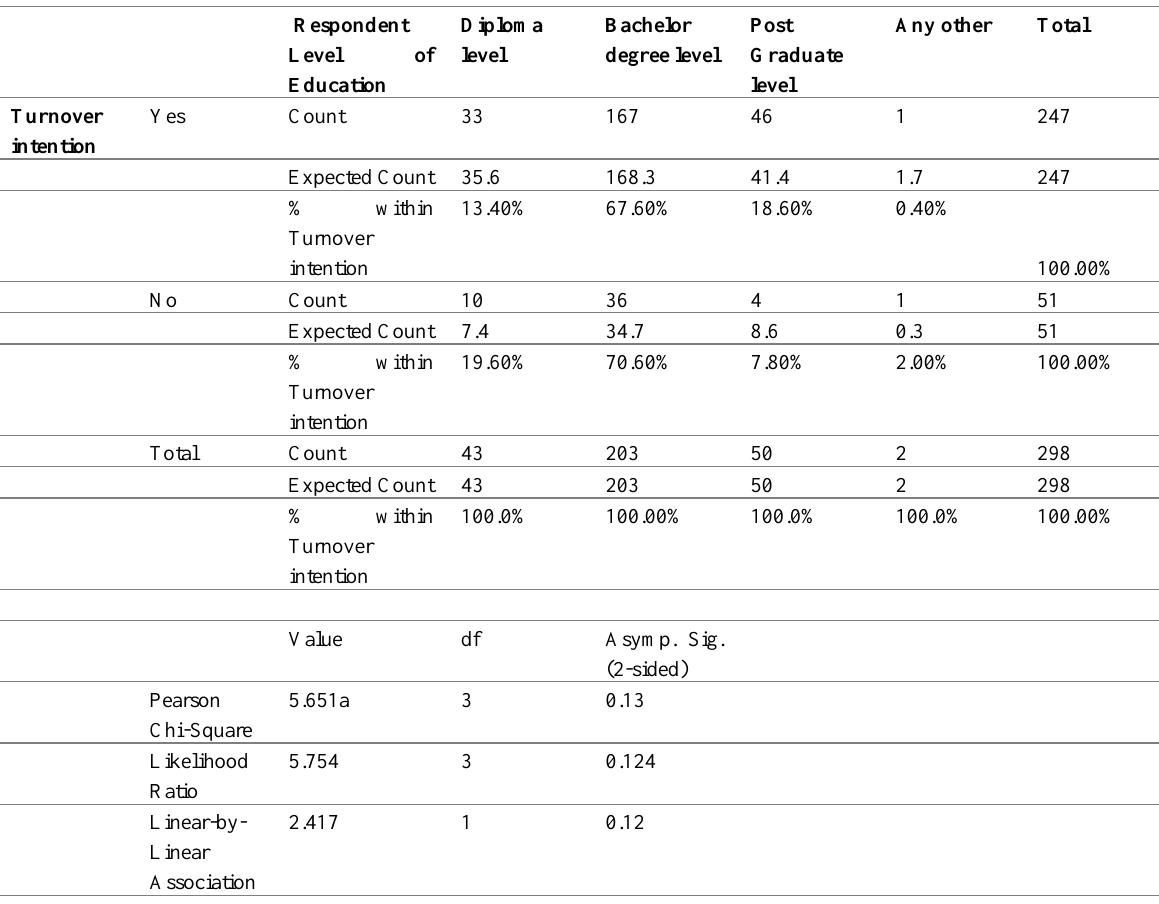
Table 7: Cross Tabulation of Turnover Intentions and Education